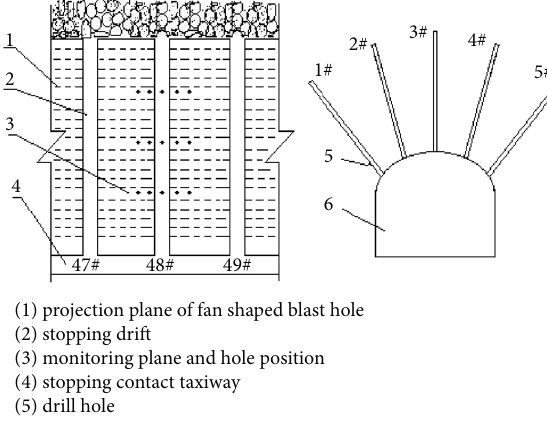
Figure 3: Layout of measuring points and holes.